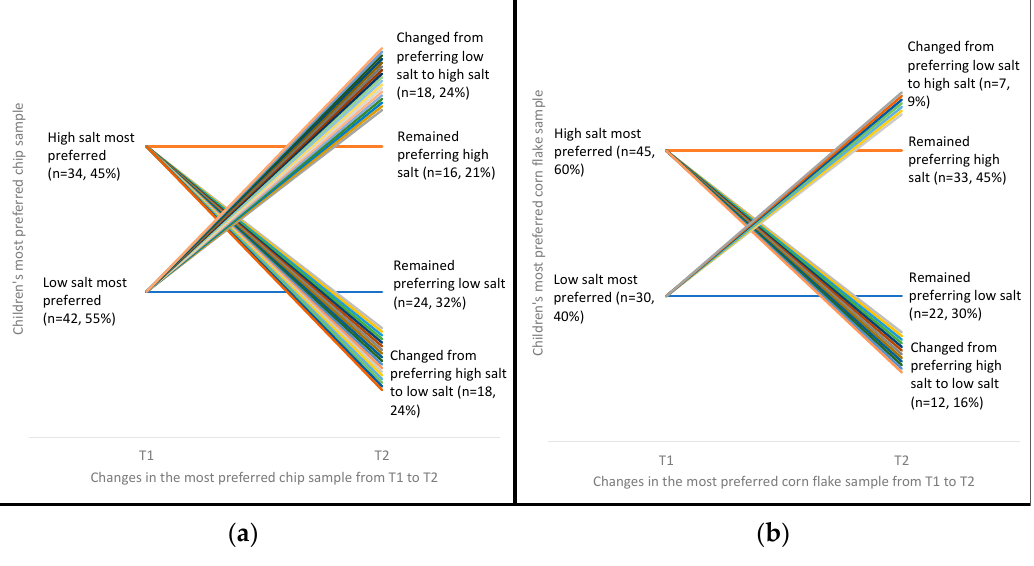
Figure 2. Participants’ most preferred potato chip ( a ) and cornflake ( b ) samples at T1 and T2 1,2,3,4,5 ; 1 Chip McNemar’s Test, p > 0.99; 2 Cornflake McNemar’s Test, p = 0.36; 3 “Low salt” group includes both low and mid salt samples; 4 n = 2 participants missing from corn flake graph due to recording errors at data collection. n = 1 missing data for T1 and n = 1 missing data for T2; 5 The ‘change’ lines are a visual representation of the number of children who changed their preference from T1 to T2—each color is a different child. As the graph is showing the changes in preference over time, the ‘remain’ lines stay the same thickness at both times points—this thickness does not represent the proportion of children who remained preferring the same sample.